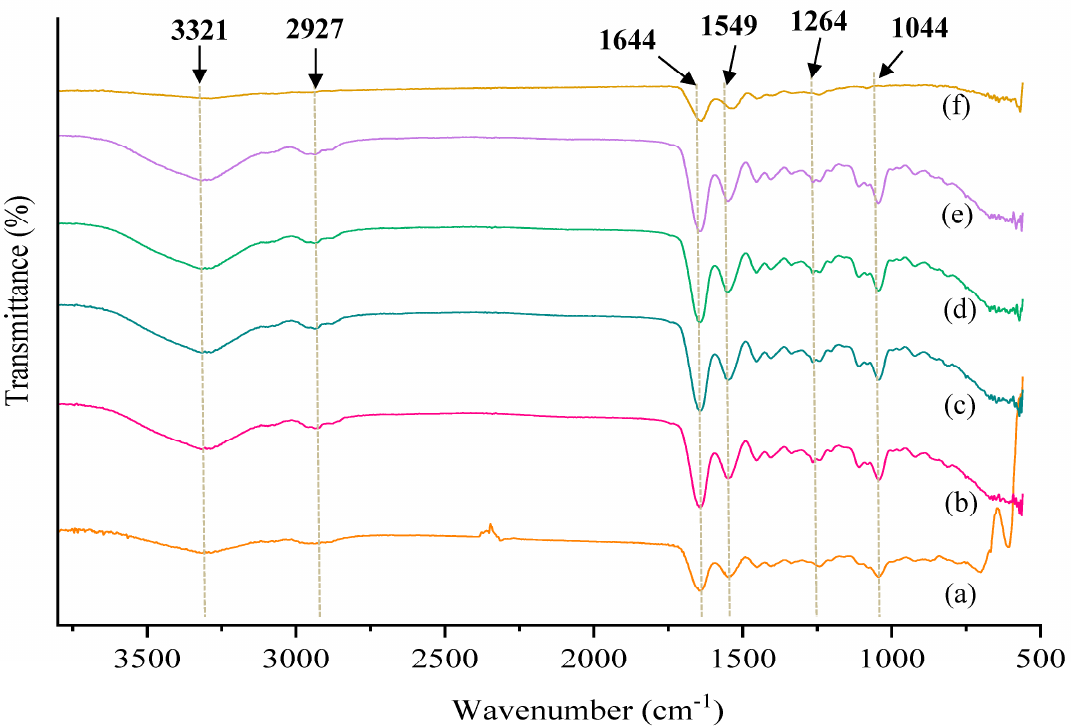
Figure 2. FTIR − ATR spectra of transglutaminase (TGase) cross-linked tilapia collagen (TC) fi lms incorporated with lysozyme (LYS). ( a ) TC-TGase-LYS-0, ( b ) TC-TGase-LYS-2, ( c ) TC-TGase-LYS-4, ( d ) TC-TGase-LYS-6, ( e ) TC-TGase-LYS-8 and ( f ) Lysozyme.